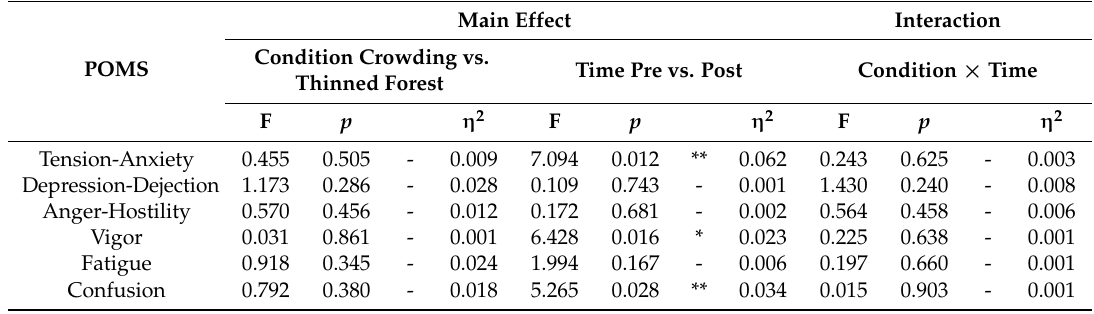
Table 7. Results for the two-way repeated-measures ANOVAs for the POMS scores.